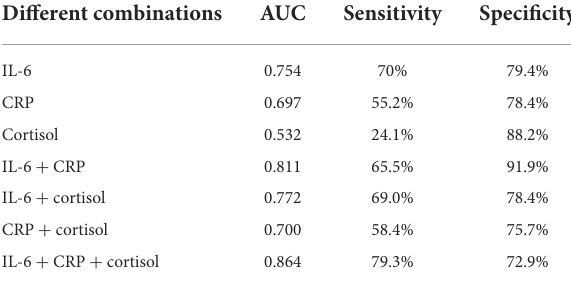
TABLE 5 AUCs of differential combination of IL-6, CRP and cortisol for discriminating MDD with/without anhedonia. Different combinations AUC Sensitivity